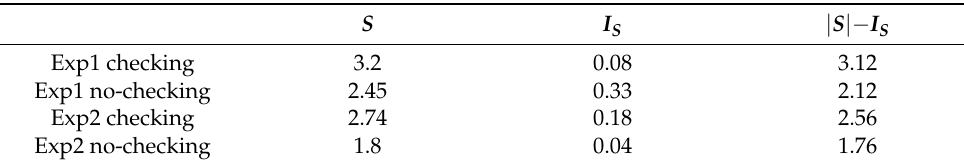
Table 10. Contextuality tests for Experiments 1 and